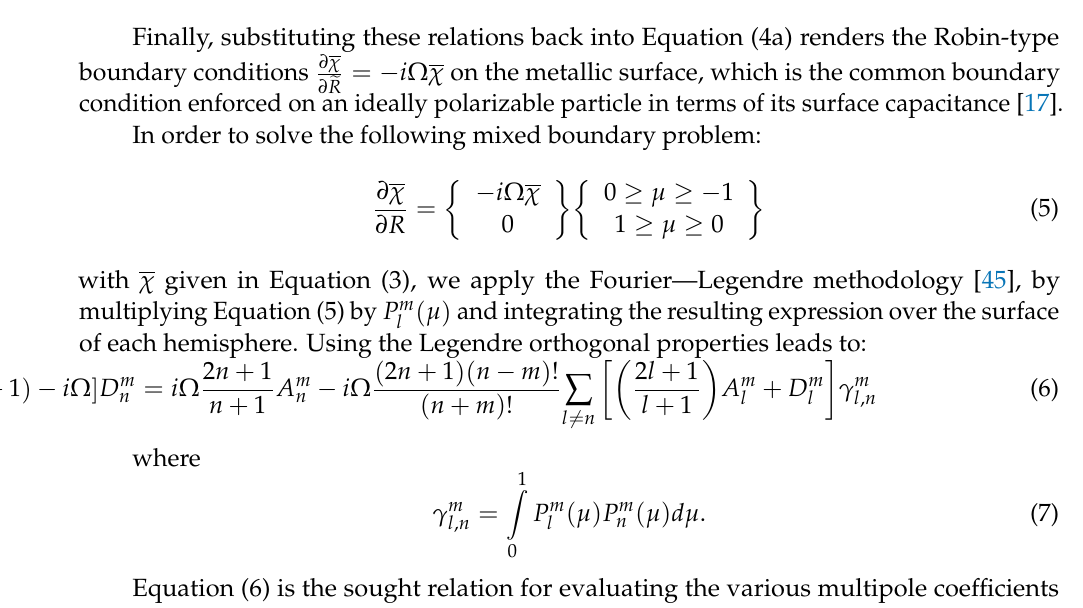
Figure 1. The interface between two homogenous hemispheres of a metallo-dielrctric (MD) Janus that is subjected to non-uniform ambient electric fields expressed in spherical coordinates (Equation (3 b )).